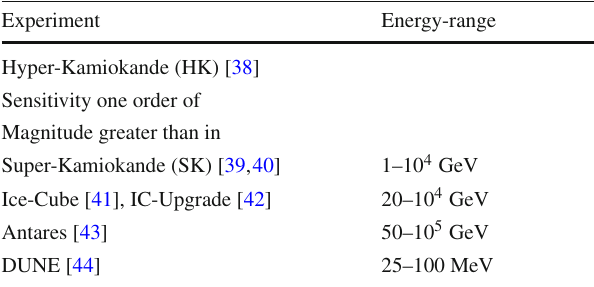
Fig. 1 Constraints on the DM mass m χ and the cut-off scale Λ for the a scalar, b vector, c Tensor1 and d Tensor2 interactions. The solid black lines in all four panels are plotted under the assumption that the Table 1 Existing and upcoming neutrino experiments measuring neu- trino flux in different energy ranges.